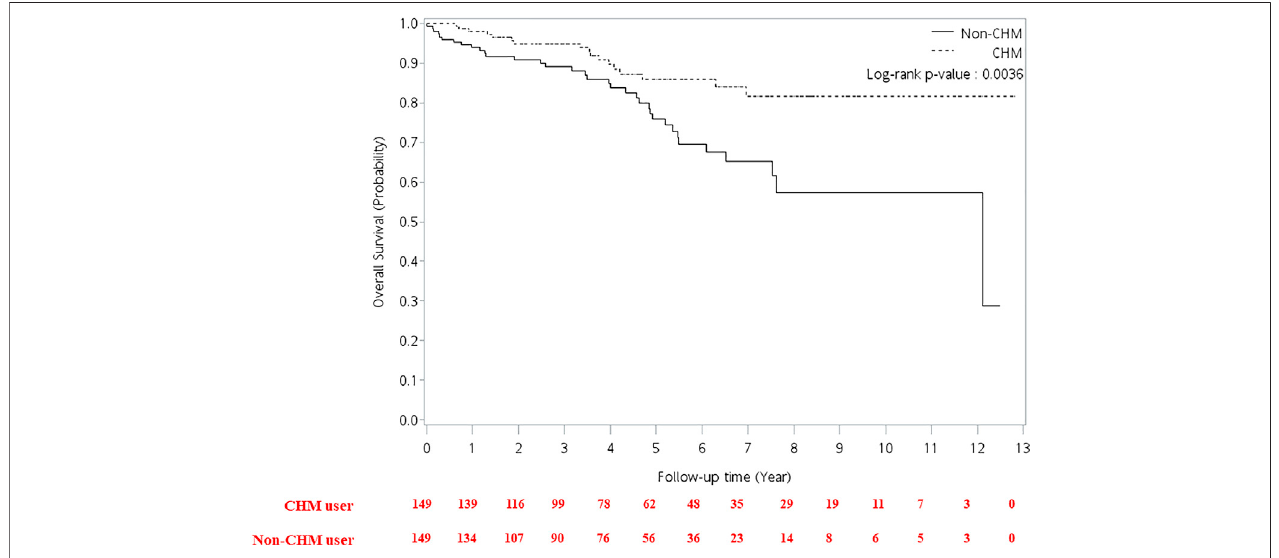
FIGURE 4 | Cumulative incidence of overall survival between CHM and non-CHM users in HIV-infected patients with osteoporosis or fractures. CHM, Chinese herbal medicine.